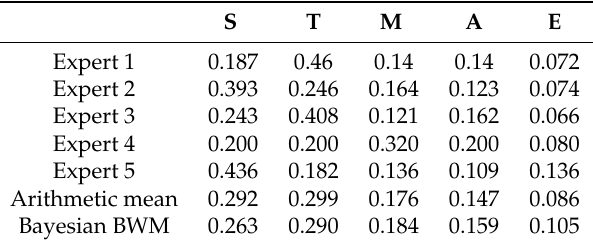
Table 4. The comparison of the weights obtained by each expert, the arithmetic mean method and the Bayesian best–worst method (BWM).